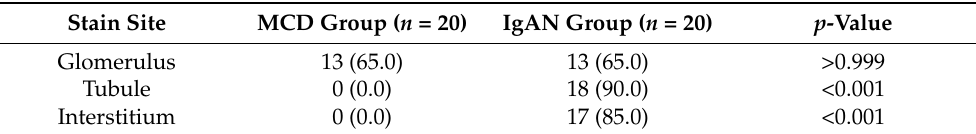
Table 2. Site of STING immunohistochemistry stain of the MCD and IgAN groups in the retrospec- tive study.